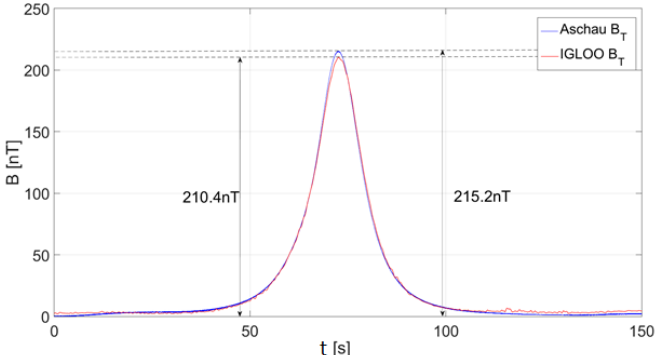
Figure 1. Vector diagram of the total magnetic field (B) of a small steel ship, length 20 m, speed 2.6 m/s, course ~230°. The three-axis magnetic field sensors were used for the measurement by two independent measurement systems: Aschau (WTD71 reference system, German) and IGLOO (Polish). Relative measurement error of the maximum value is 2.2% (author’s source).